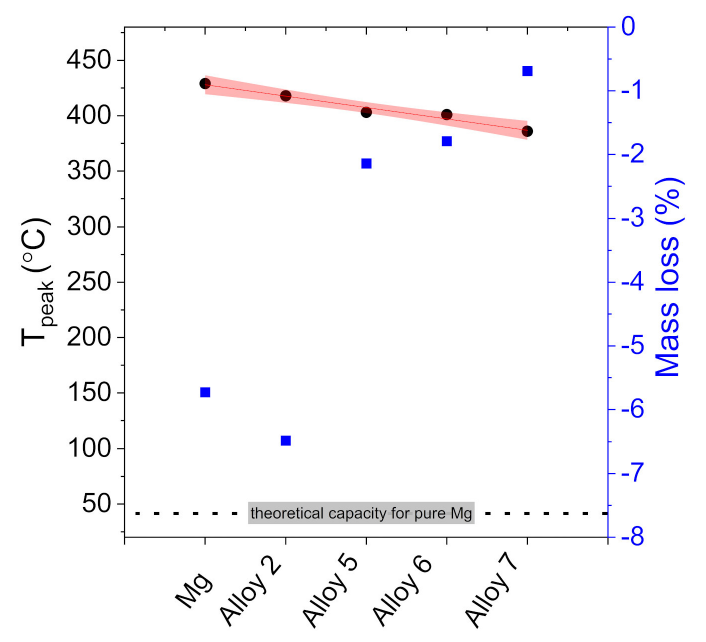
Figure 12. Average mass loss and decomposition peak temperatures for selected samples.